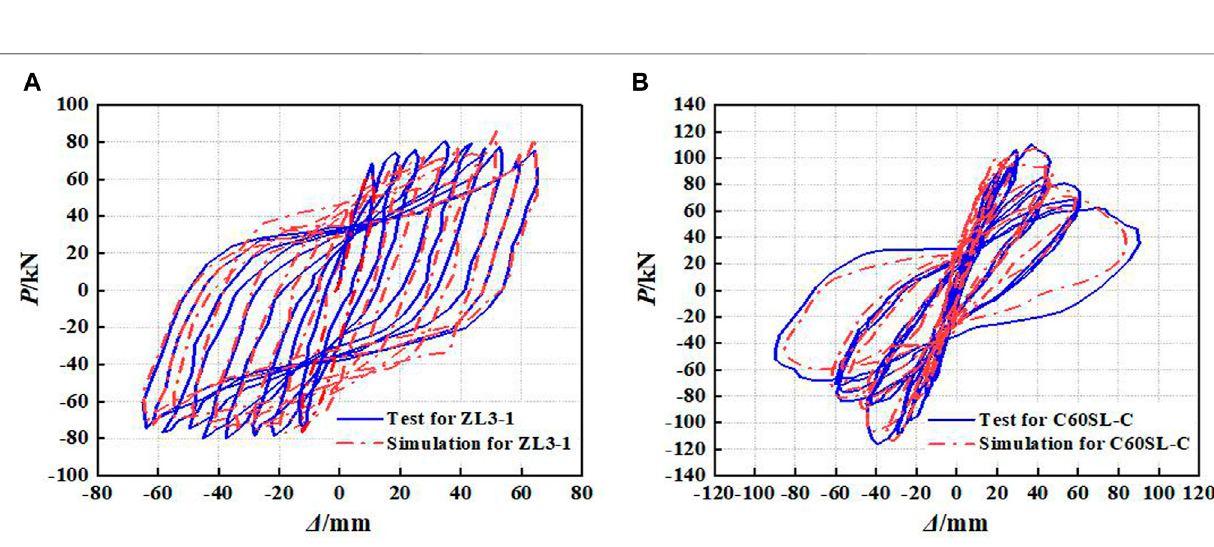
Frontiers in Materials |